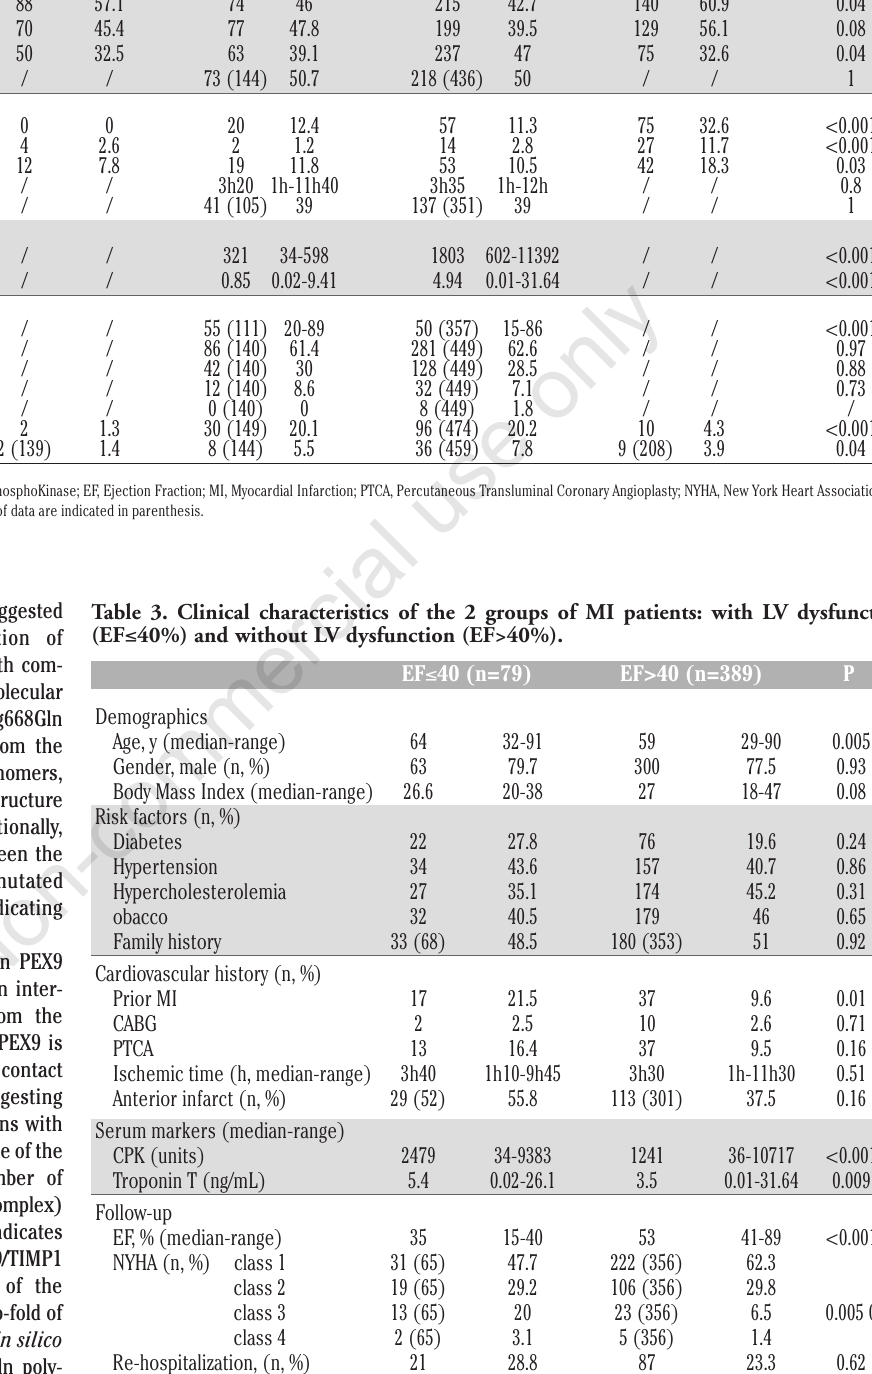
Table 2. Characteristics of controls, NSTEMI, STEMI and angina patients. Demographics Age, y (median-range) Risk factors (n, %) Diabetes